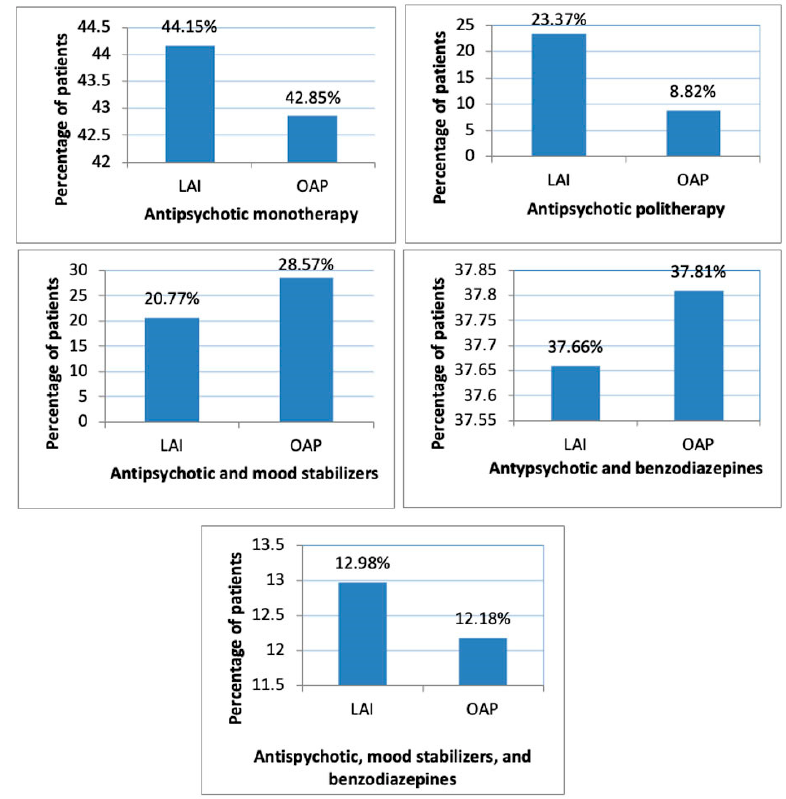
Figure 2. Concomitant treatment in LAI versus OAP groups.